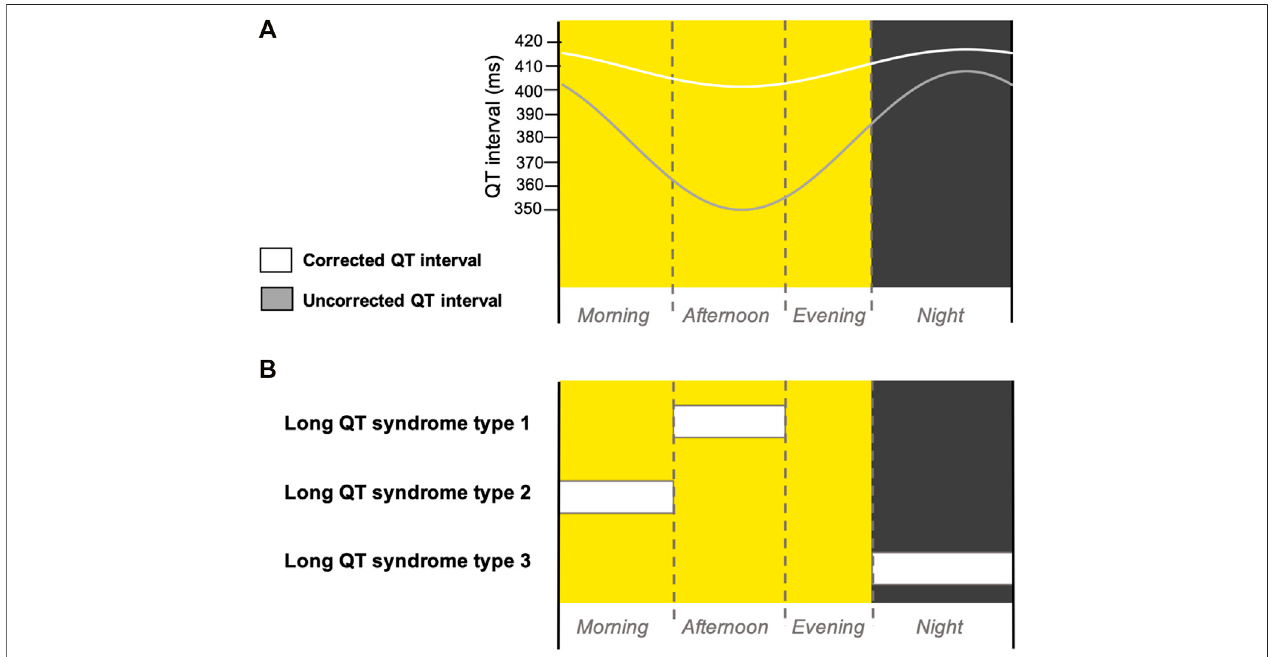
FIGURE 1 | Diurnal variation in QT interval and cardiac events in LQTS patients. (A) Schematic cartoon diagram of the diurnal variation of corrected (white) and uncorrected (grey) QT intervals (Bonnemeier et al., 2003; Smetana et al., 2003) over a long day photoperiod diurnal cycle. (B) Schematic summary of the times of day when patients with different subtypes of LQTS most frequently experience cardiac events (Matsuo et al., 1999; Takigawa et al., 2012; Aizawa et al., 2016; Pérez-Riera et al., 2018). Yellow background indicates daytime and grey background indicates night-time. Dotted line indicates the transition between morning, afternoon and evening phases of the diurnal